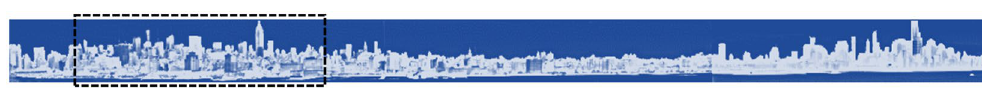
Figure 2. Eight kilometers along Manhattan West side was scanned for eight days at approximately 3 minute intervals. (image by python https://codeshare.io/5ONkBP script, one wavelength from data cube) Results of analysis presented refer primarily to the portion shown above within the dashed line, extending approximately from 14 th to 60 th